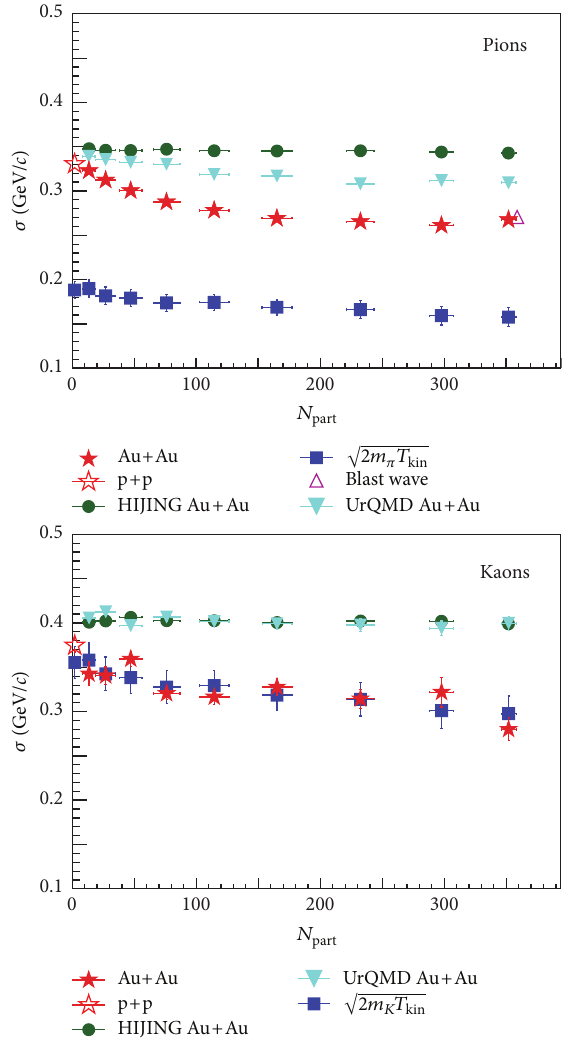
) Figure 19: The balance function width 𝜎 extracted from 𝐵(𝑞 inv for identified charged pions and kaons from Au+Au collisions at √𝑠 = 200 GeV and pp collisions at √𝑠 = 200 GeV where 𝜎 is NN NN the width. Filtered HIJING and UrQMD calculations are shown for = 200 GeV. Values pions and kaons from Au+Au collisions at √ 𝑠 NN from Au+Au collisions, where 𝑚 is the mass are shown for √2𝑚𝑇 kin is calculated from identified particle of a pion or a kaon, and 𝑇 kin spectra [41]. The width predicted by the blast-wave model [39] is also shown for pions. The graph is taken from